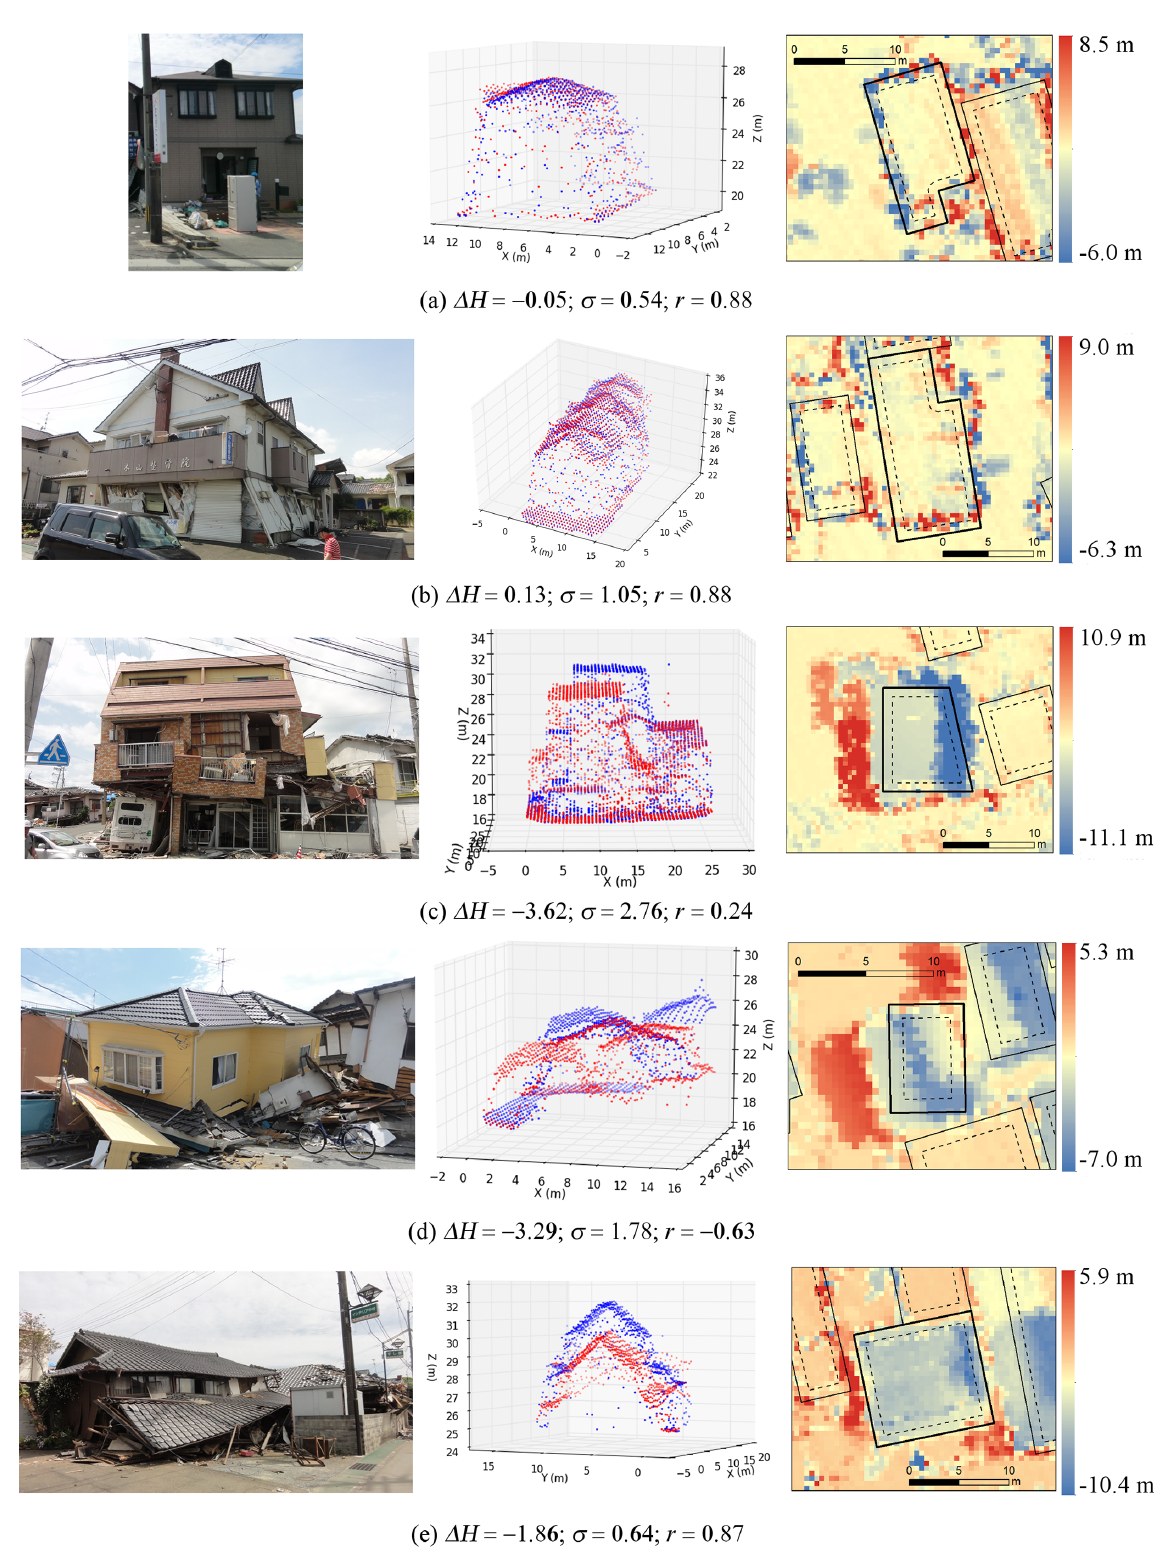
Figure 4. Examples of collapsed buildings from the lidar data. The left column shows the photos taken after the mainshock by the authors. The middle column shows the lidar data, wherein the blue points depict the BDSM and the red points the ADSM. The right column shows the elevation differences between the two DSMs, wherein the solid lines depict the building footprints and the dashed lines depict the footprint reduced by